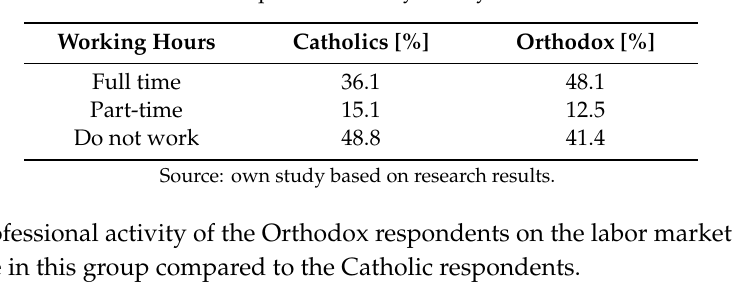
Table 6. Work performance by surveyed